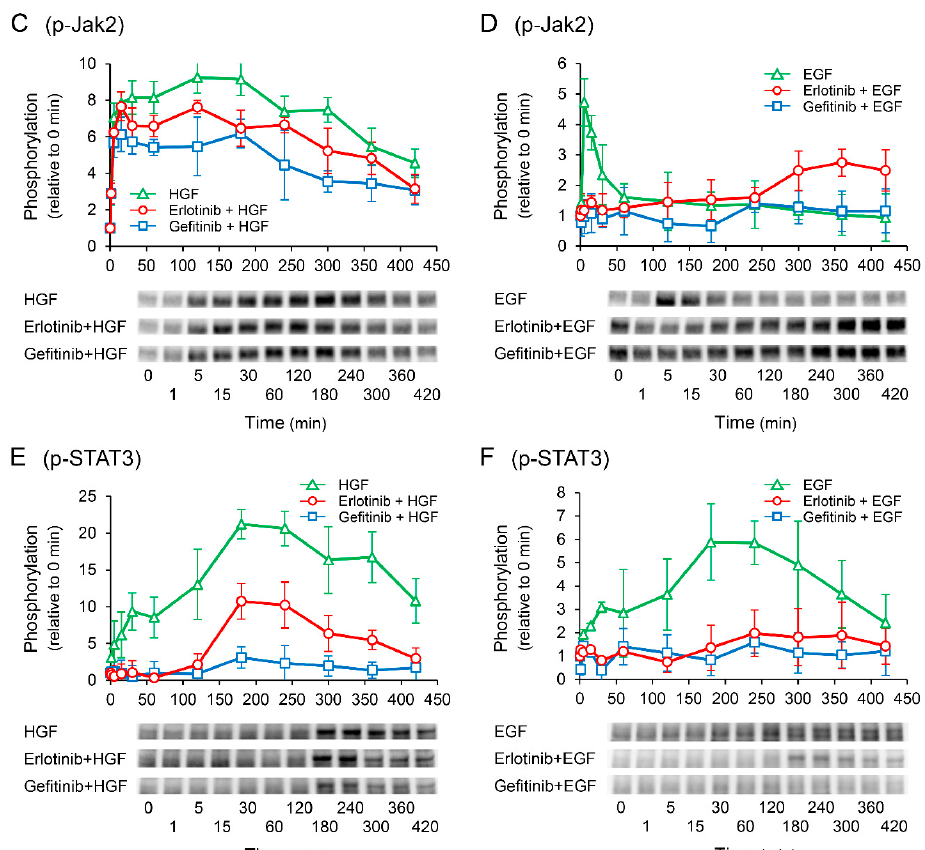
Figure 5. Effects of erlotinib and gefitinib on growth factor-induced phosphorylation of downstream signaling molecules. HepG2 cells were cultured for 24 h in serum-starved medium. Thereafter, HGF (50 ng/mL) or EGF (50 ng/mL) was added to the medium. Cells were pretreated with erlotinib (5 µM) or gefitinib (1 µM) 15 min before treatment with growth factors. Total protein was collected at the indicated time points. The relative amount of phosphorylated protein in each band was quantified by ImageQuant TL software, and phosphorylation trends of extracellular signal-regulated kinase (Erk) ( A , B ), Janus Kinase 2 (Jak2) ( C , D ), and signal transducer and activator of transcription 3 (STAT3) ( E , F ) after treatment with growth factors were plotted on graphs. The intensity of phosphorylation is expressed relative to that at 0 min. Western blot analysis was performed in 3 experiments for 3 different preparations, and representative blots are shown. Each bar represents the mean ±